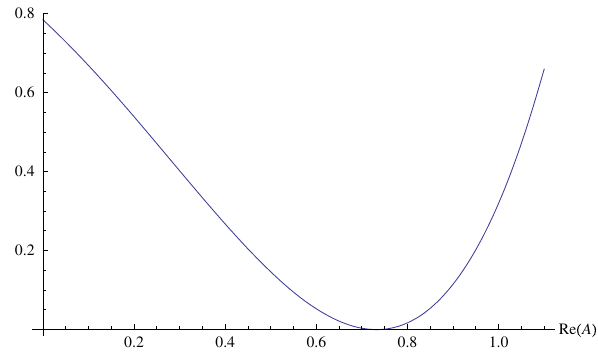
Fig. 2 The real slice at Im ( A ) = 0 of Fig. 1 around the minimum of ˜ V definite scalar potential, a spontaneous SUSY breaking and a de Sitter vacuum after inflation. Our approach does not preserve the R